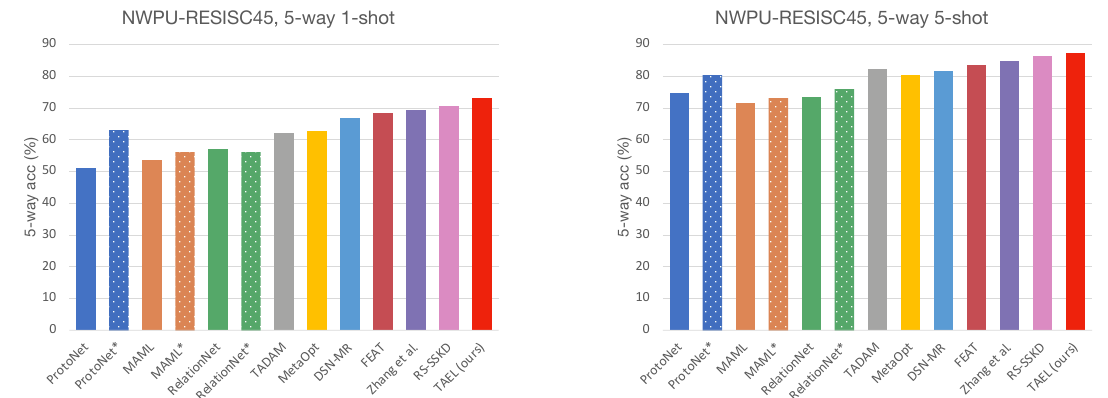
Figure 7. The few-shot classification performance (with 95% confidence intervals) on the NWPU-RESISC45 dataset; the bars with dots indicate the re-implementation of approaches with ResNet-12 backbone.